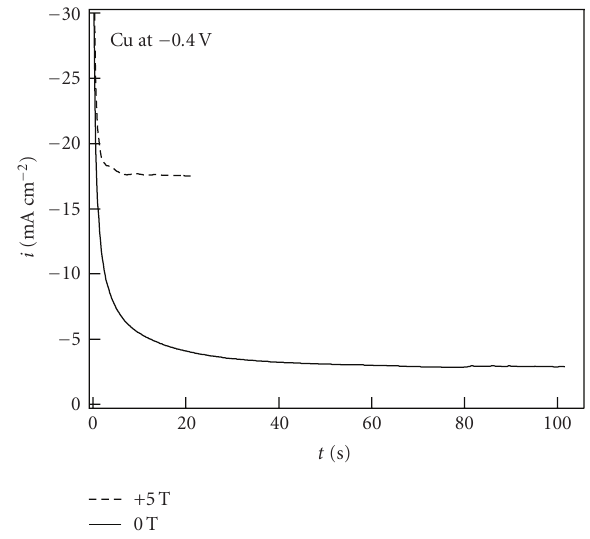
Figure 3: Current-time curves during the Cu electrodeposition in 0 T and